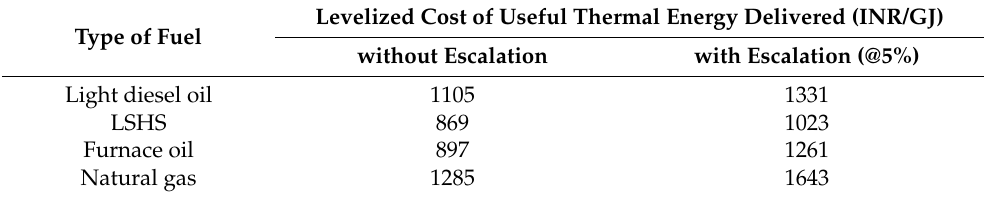
Table 6 for two scenarios: one for the case of uniform fuel price for the entire life period of the system, and the other with an annual price escalation by 5% in each year till the end-of-life period. Table 6. Expenditure to be incurred for conventional process heating